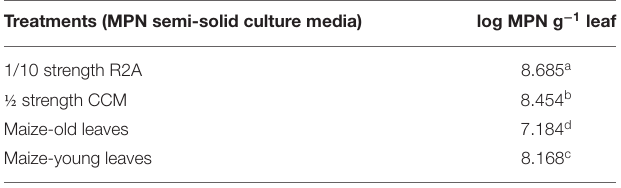
TABLE 1 | MPN estimates of bacterial endophytes of endo-phyllosphere of maize as developed on semi-solid culture media of leaf-strip-based culture media